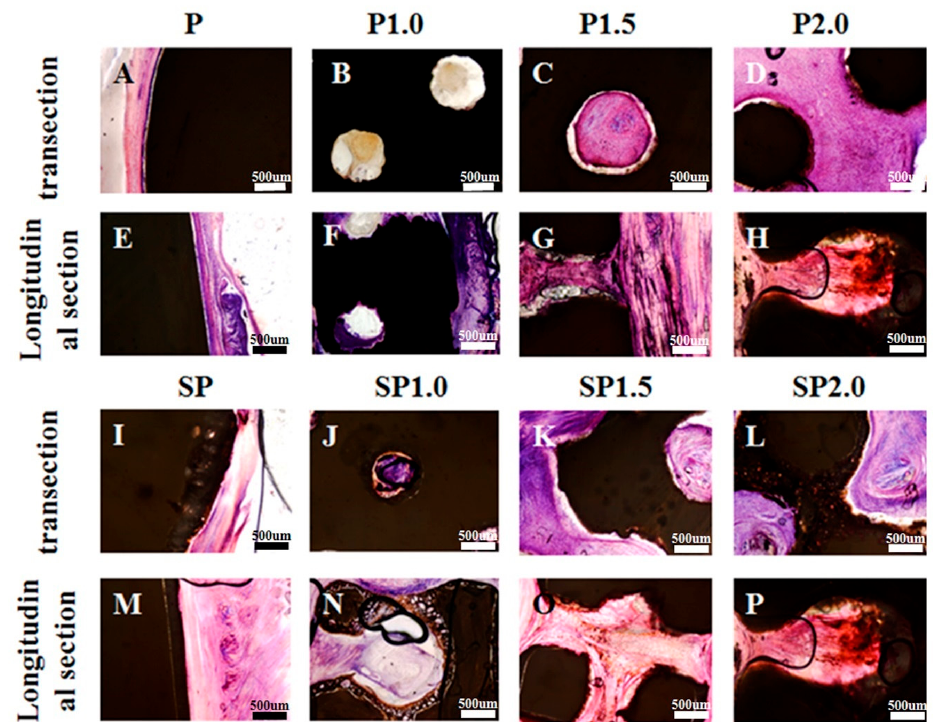
Figure 6. Hematoxylin and eosin (HE) staining images of different transplanted peek specimens after 4 weeks. ( A ) Transection HE staining images of group ( A ) P, ( B ) P1.0, ( C ) P1.5, ( D ) P2.0, ( I ) SP, ( J ) SP1.0, ( K ) SP1.5, and ( L ) SP2.0 with soft tissue. Longitudinal sections of HE staining images of group ( E ) P, ( F ) P1.0, ( G ) P1.5, and ( H ) P2.0, ( M ) SP, ( N ) SP1.0, ( O ) SP1.5, and ( P ) SP2.0 with soft tissue.